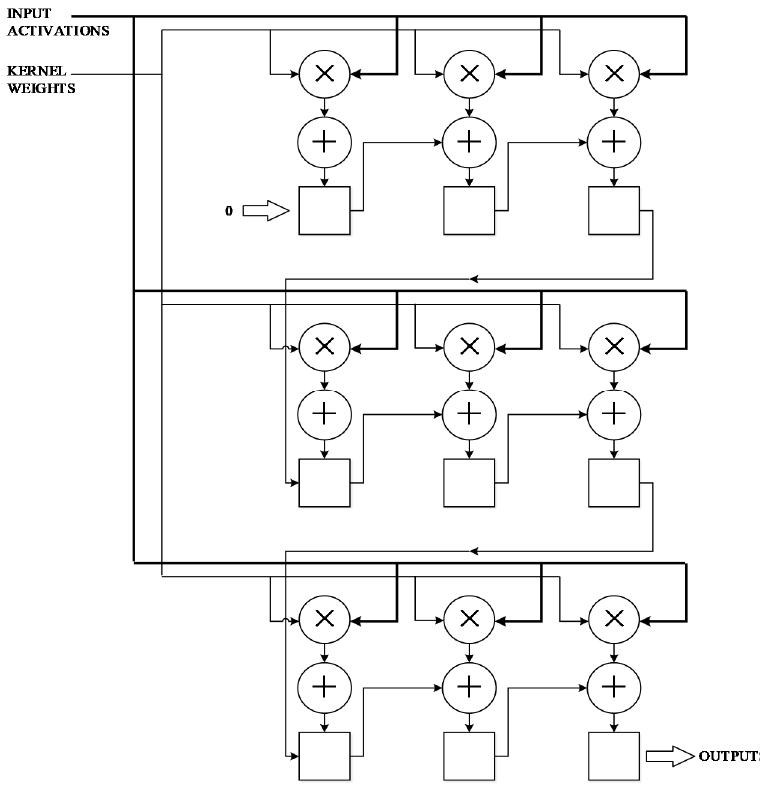
Figure 5. The structure of the inner product unit of Convolution Layers.